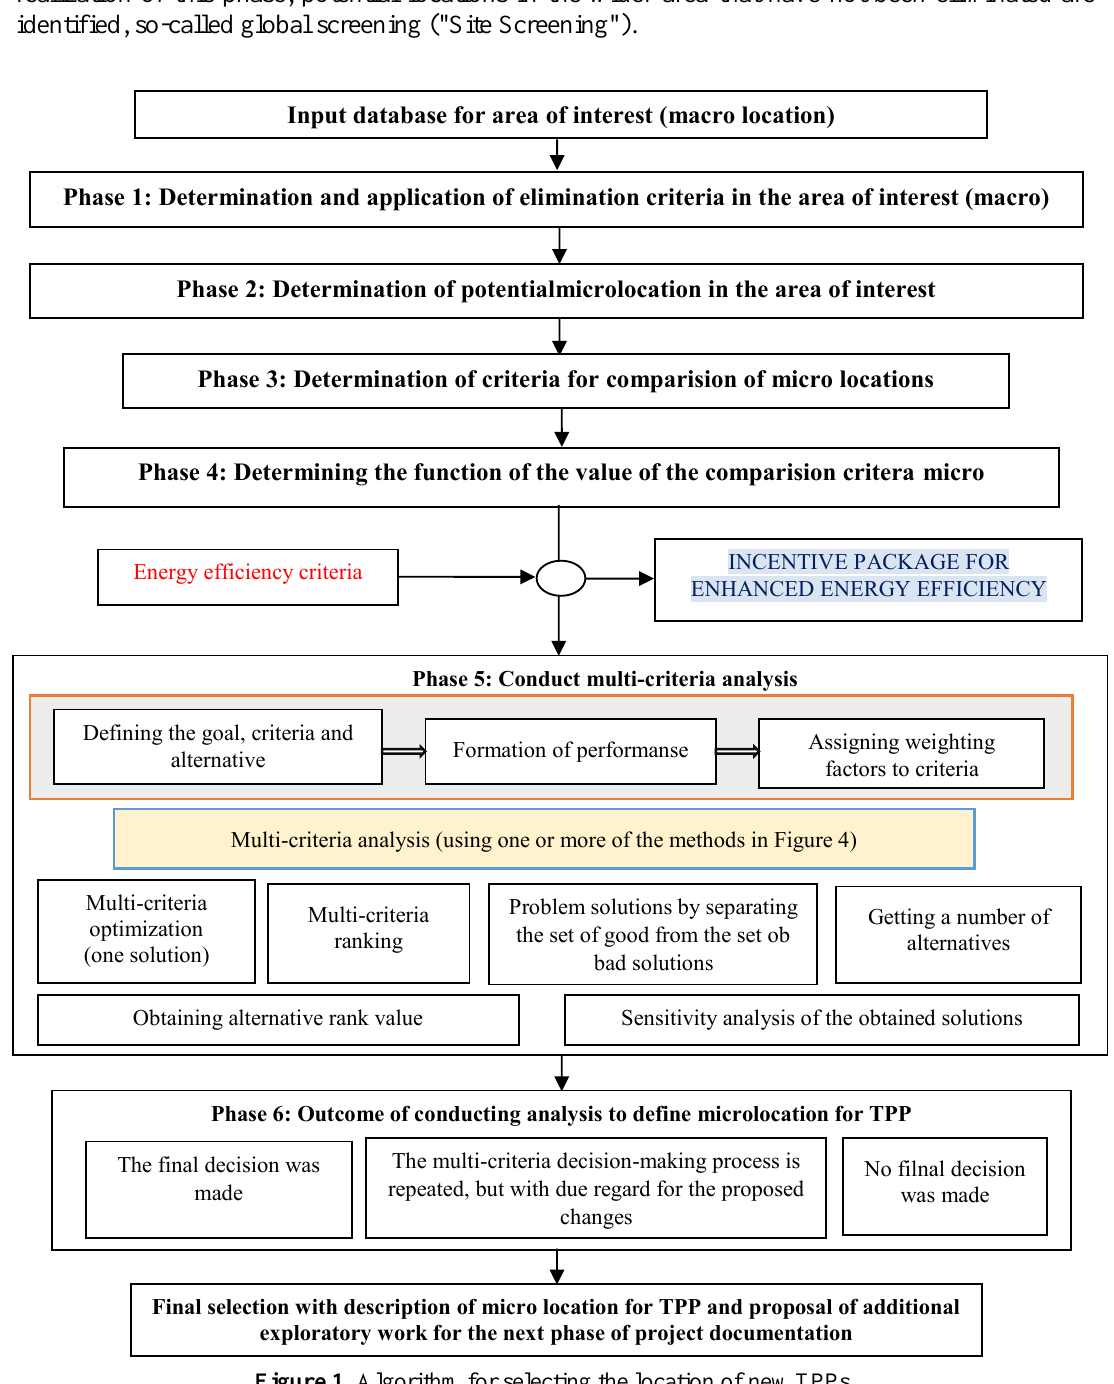
Figure 1. Algorithm for selecting the location of new